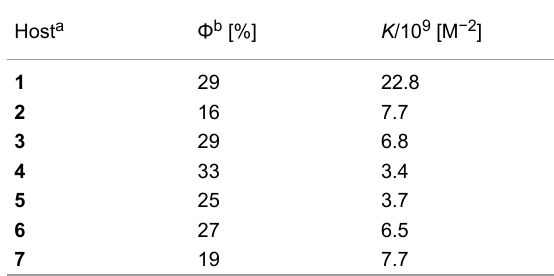
Table 1: Influence of CDs on the quantum yield Φ of the photodimer- ization of ANT and 1:2 binding constant K